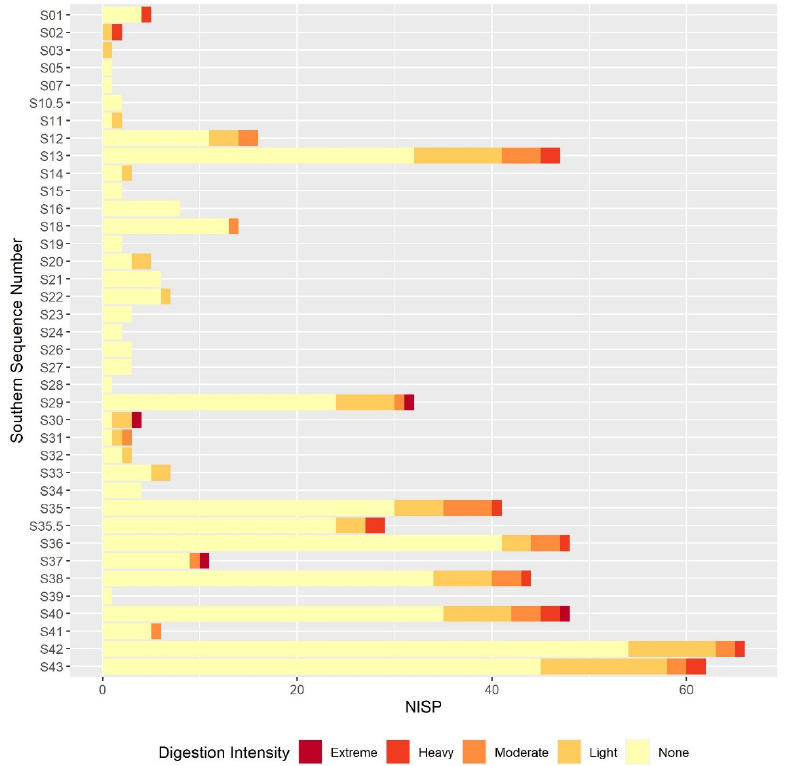
Figure 7. Observed isolated molar digestion intensities in the southern sequence. NISP: number of identifiable specimens.